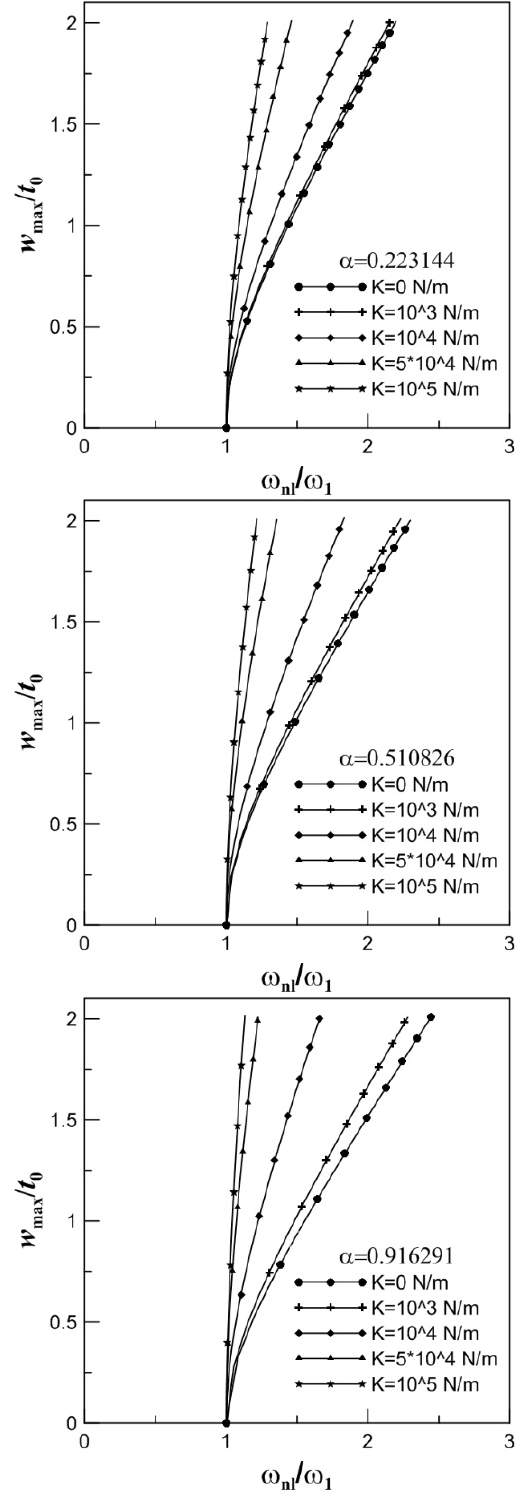
Figure 11: Backbone curve of AFG exponential taper beam (︀ E ( ξ ) = E )︀ on elastic 0 e ξ , ρ ( ξ ) = ρ 0 e ξ